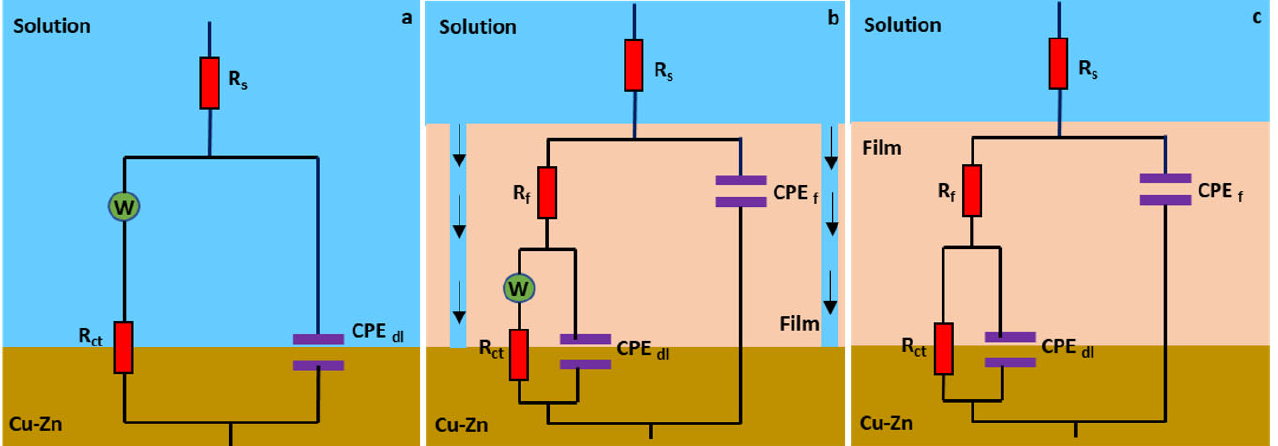
Figure 8. Equivalent circuit models used to fit electrochemical impedance data for ( a ) the blank solution, ( b ) 0.05 and 0.10 mM concentrations of inhibitor solutions showing Warburg impedance, and ( c ) 0.25 and 0.50 mM concentrations of inhibitor solutions.